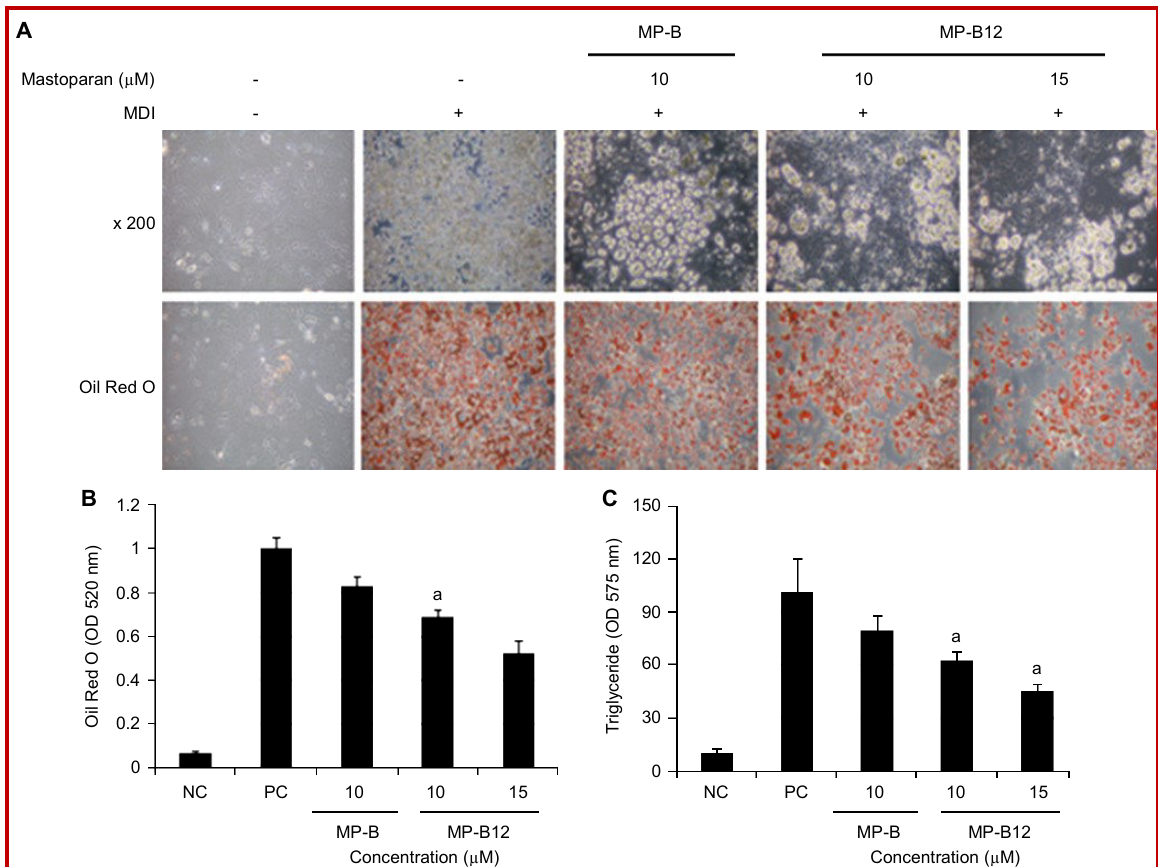
Figure 3: Effect of MP-B peptides on adipogenesis in 3T3-L1 cells. (A) Intracellular lipid accumulation was assessed by Oil Red O staining and observed using an inverted microscope. Oil Red O stained adipocytes were captured at x200 magnification. (B) The absorbance of Oil Red O dissolved in isopropanol was determined at 520 nm. (C) Lipid accumulation was assessed by measuring intracellular triglyceride levels. Con, 3T3-L1 preadipocytes; MDI, fully differentiated adipocytes; MP-B 10 μ M, fully differentiated adipocytes (MDI + 10 μ M MP-B); MP-B12 10 μ M, fully differentiated adipocytes (MDI + 10 μ M MP-B12); MP-B12 15 μ M, fully differentiated adipocytes (MDI + 15 μ M